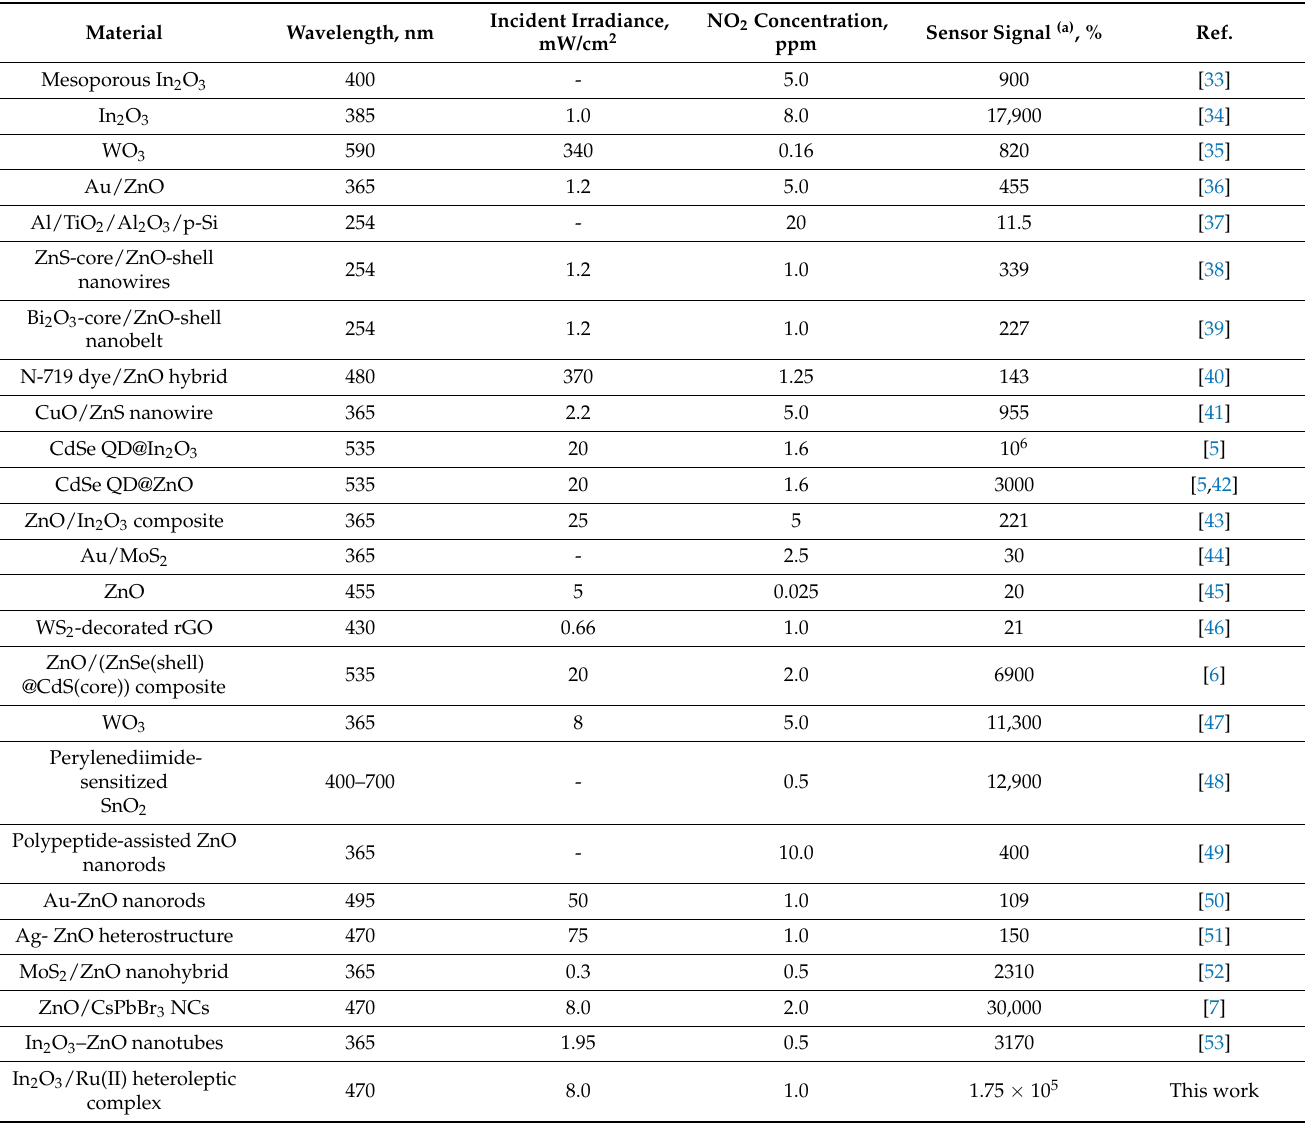
Table 7. Comparison of the light-activated (with LED) NO 2 gas sensor performances at room temperature for different